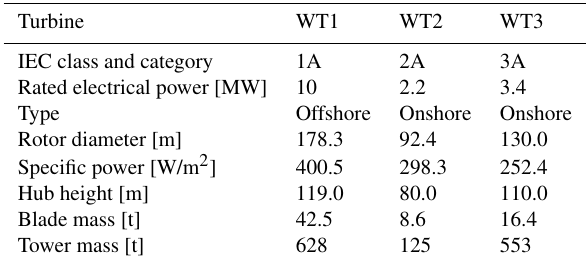
Table 4. Principal characteristics of the three reference